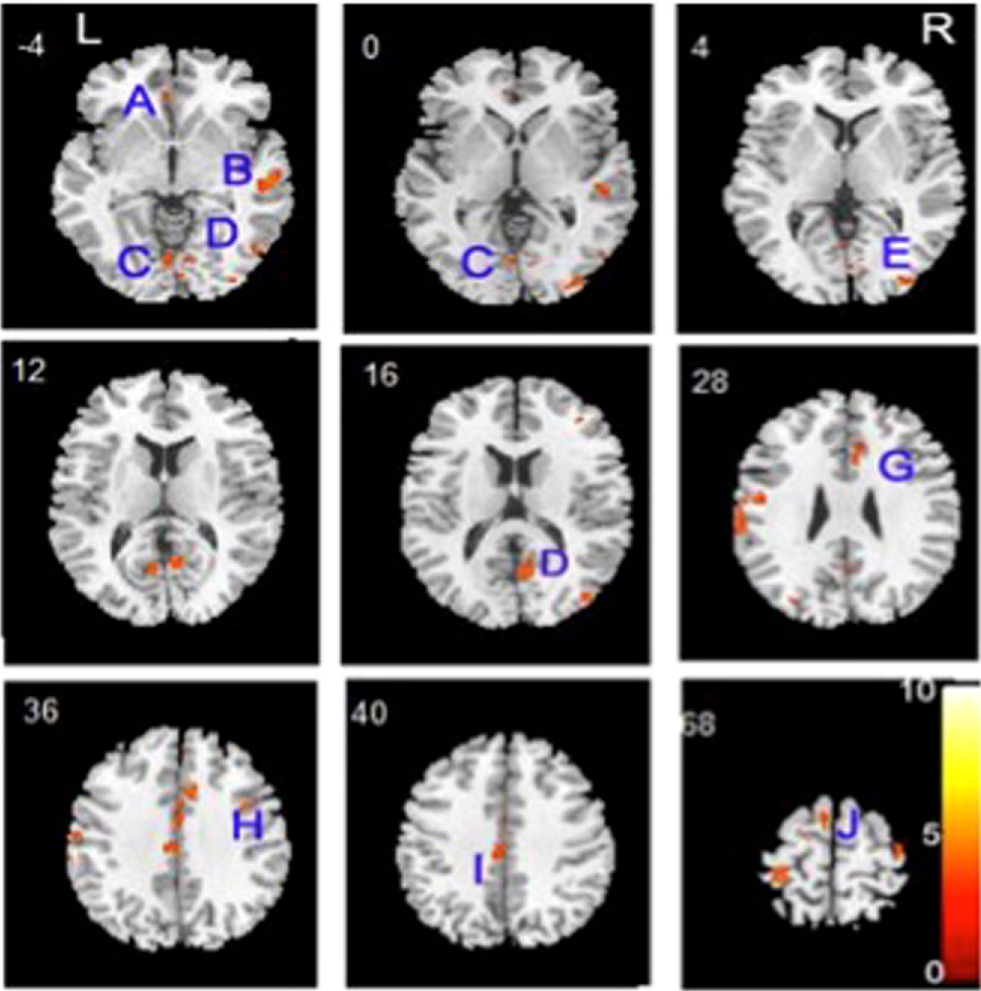
Figure 3. Relative to healthy comparison subjects, the gray matter volume loss of adult-onset, drug-naïve first-episode schizophrenia patients was centered on the cingulo-fronto-temporal module and right occipital regions. ( A ) Left anterior cingulate; ( B ) Right middle temporal gyrus; ( C ) Left occipital lobe lingual gyrus; ( D ) Right posterior cingulate; ( E ) Right middle occipital gyrus; ( G ) Right cingulate gyrus; ( H ) Right superior frontal gyrus; ( I ) Left cingulate gyrus; ( J ) Left superior frontal gyrus.